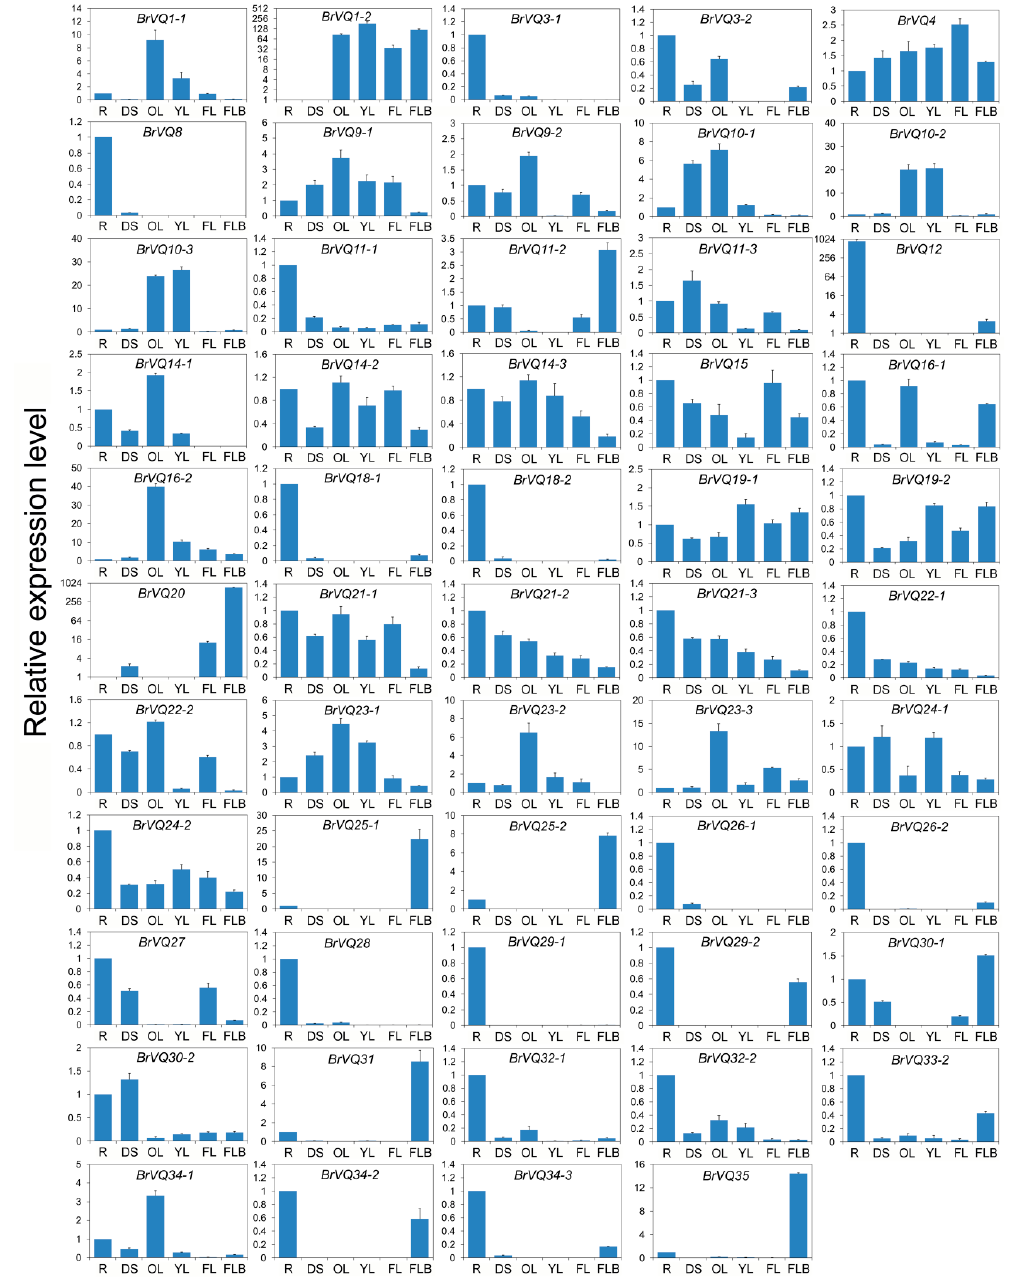
Figure 7. Expression analysis of the BrVQ genes in different tissues of Chinese cabbage. The surveyed tissues include root(R), dwarf stem (DS), old leaf (OL), young leaf (YL), flower (FL), and flower bud (FLB). Expression levels of the BrVQ genes were normalized to those of BrActin and shown relative to their expression in R, except for BrVQ1-2 and BrVQ12 , whose expression level was relative to that in DS. The 2 −ΔΔ Ct method was used to calculate the expression levels of target genes in different tissues. The expression levels of BrVQ1-2 , BrVQ12 , and BrVQ20 are shown by log2.